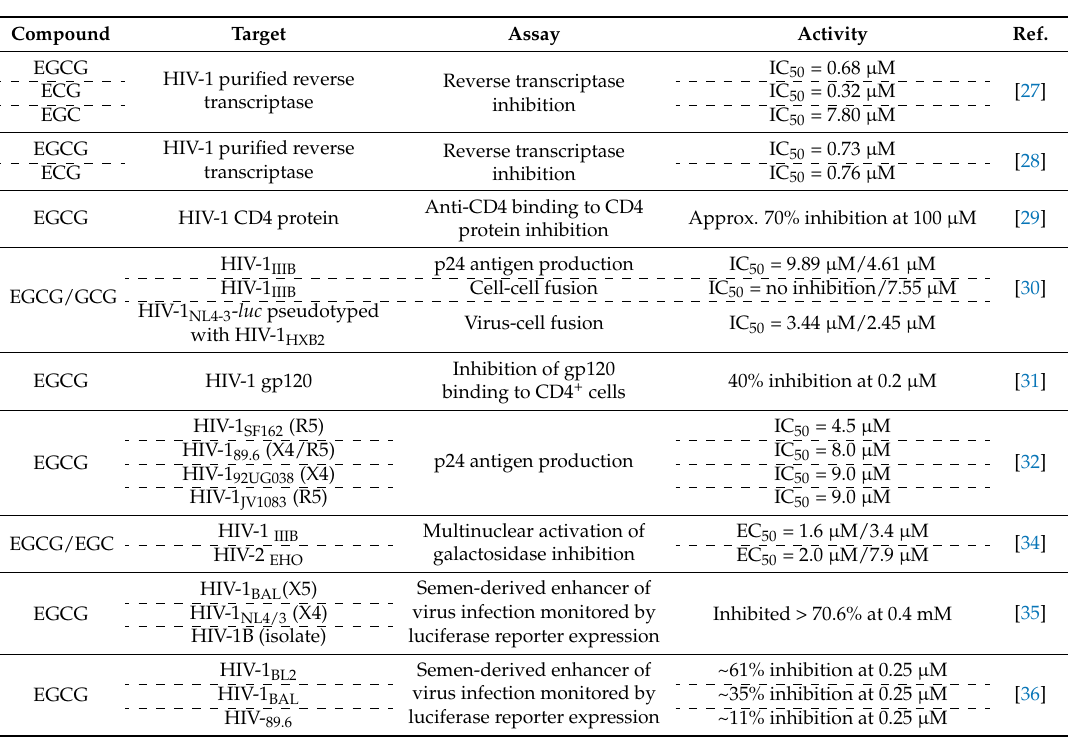
Table 3. Summary of Antiviral Activity of Catechins on